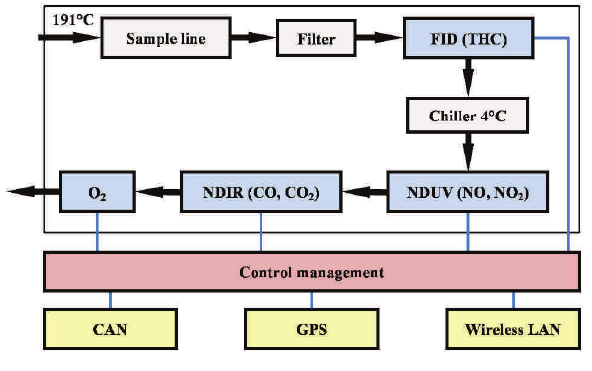
Fig. 3. SEMTECH DS operating schematic [10]